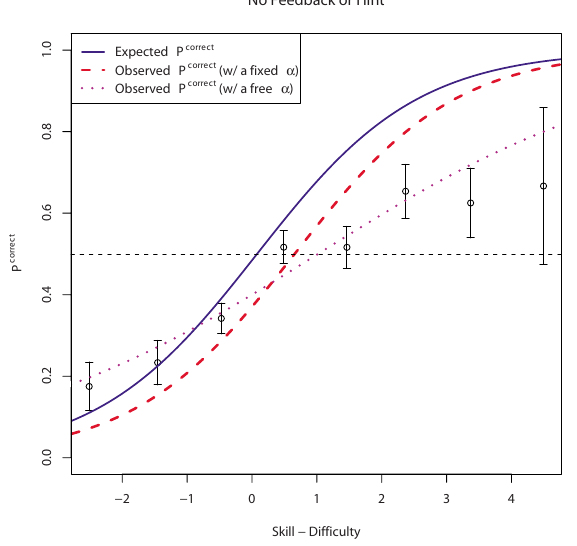
FIG. 4. (cid:1) Color (cid:2) Logistic fits to the second attempt of students when students neither received feedback from the tutor nor used hint or subtask.